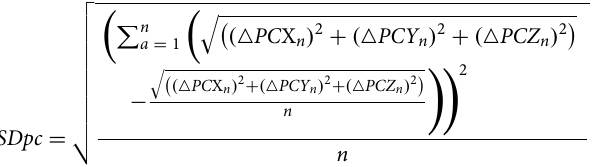
were executed using the Brainsight software. Firstly, a reference point was set on the posterior margin of the precentral gyrus, aligned with the “omega” representing M1 on both the affected and healthy hemispheres, it was set manually by the average visual marking of principal examiner and the referred surgeon of the case in order to compensate for tumoral distortion, the setting of the point was defined as the apex of the precentral “omega” on the border of the central sulcus, when the distortion did not allow for visual identification of the precentral gyrus margin, a standardized stereotactic MNI map was used. Then, the Euclidian center of gravity was calculated for the positive motor points on both hemispheres, creating a center of gravity (CG) point. The first parameter, (cid:49) L was the distance between the reference point and CG. The second parameter was the dispersion (SDpc) from all positive points regarding